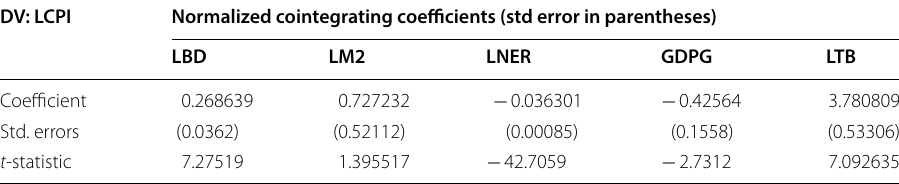
Table 5 Results of the normalized cointegrating vector Source : Normalized output from cointegration test